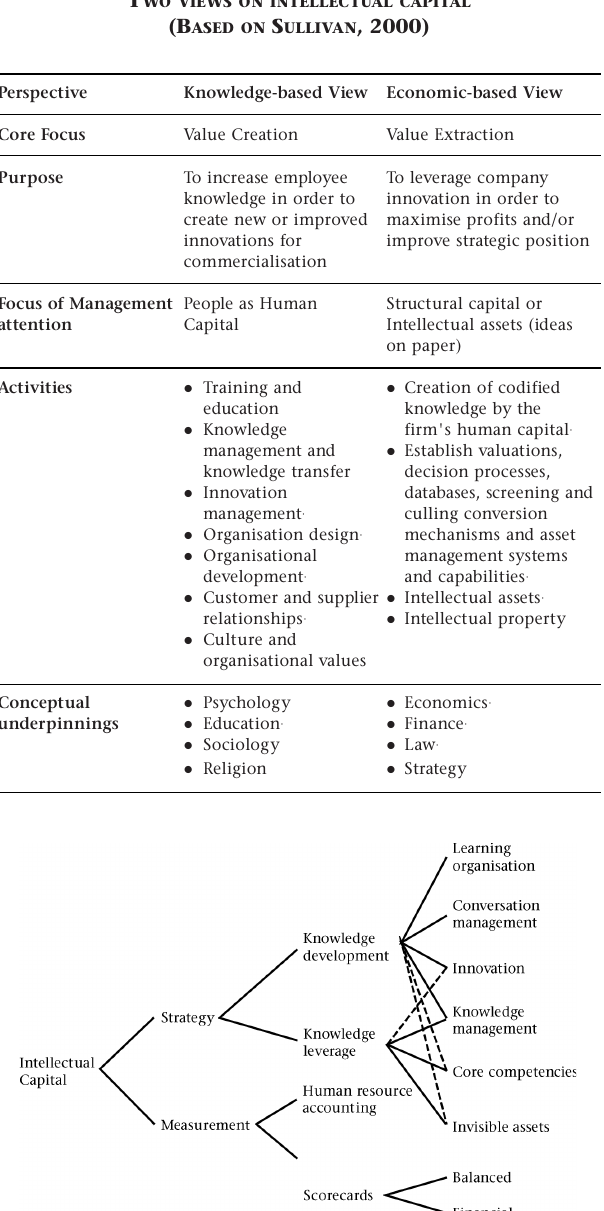
Figure1: Conceptual roots of Intellectual Capital (Roos et al., 1997).